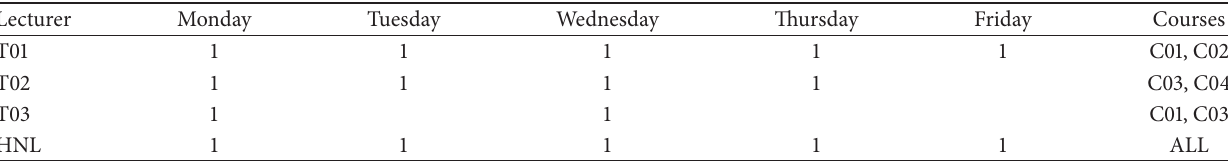
Table 2: Availabilities.